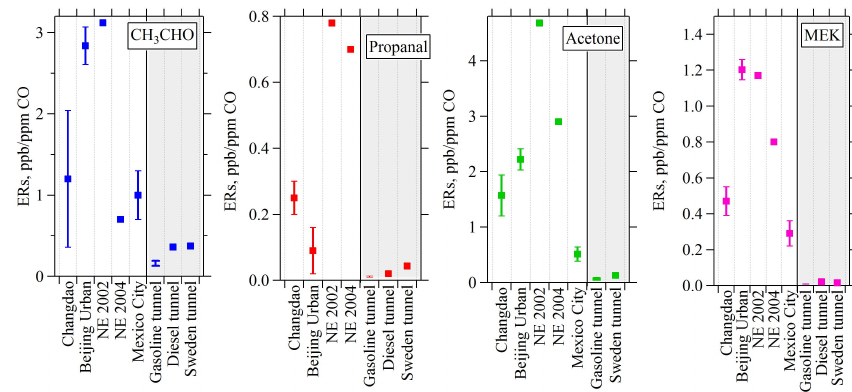
Fig. 4. Comparison of emission ratios of selected OVOC species in Changdao and those reported in Beijing (Yuan et al., 2012), the northeast- ern US in 2002 and 2004 (Warneke et al., 2007) and Mexico City (Bon et al., 2011). Emission ratios determined from tunnel experiments, including gasoline and diesel vehicle emissions in California (Ban-Weiss et al., 2008) and the results from a tunnel in Sweden (Kristensson et al., 2004), are shown in the shaded gray areas of the graph.